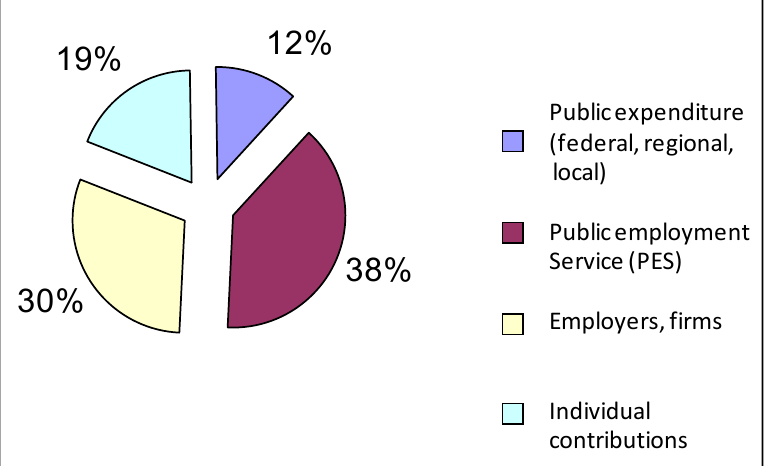
Source: Statistics Austria, Microcensus 2003, estimation Lassnigg, Vogtenhuber